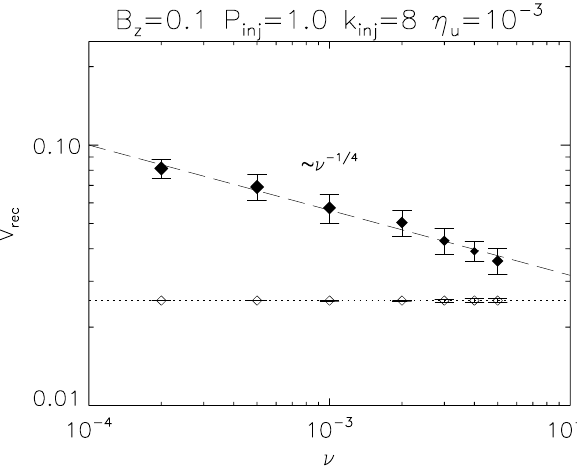
Fig. 7. The dependence of the reconnection speed V rec on P inj up- dated by symbols from new models. Blue symbols show models with new driving in which the eddies where injected in magnetic field instead of velocity, as in the previous models (black symbols). The dotted line corresponds to the Sweet-Parker reconnection rate for models with η u = 10 − 3 . A unique red symbol shows the recon- nection rates from model with new driving in velocity performed with higher resolution (512x1024x512) and resistivity coefficient reduced to η u = 5 · 10 − 4 . Error bars represent the time variance of V rec . The size of symbols corresponds to the error of V rec (the way we calculate errors is described in Sect. 4.1).